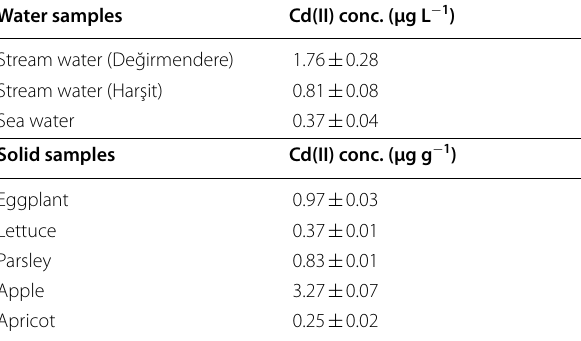
Table 9 Cd(II) levels of real samples (eggplant, lettuce, parsley, apple, and apricot amount: 0.750 g, sea and stream water volume: 500 mL, final volume: 5.0